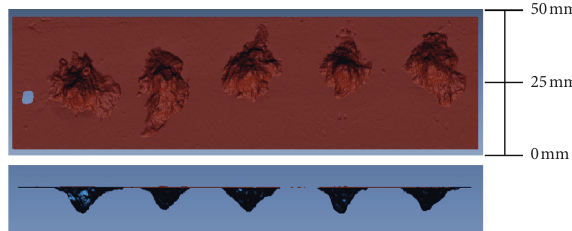
Figure 9: Images of rock volumes fractured during button impact testing.